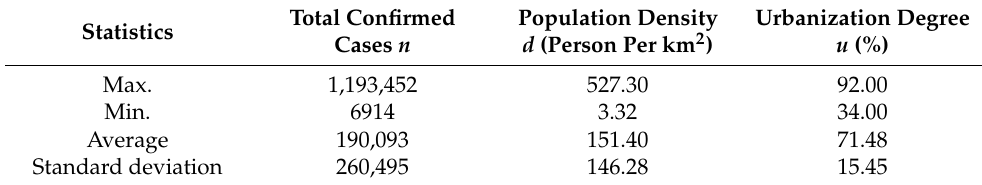
Table 2. Descriptive statistics of study